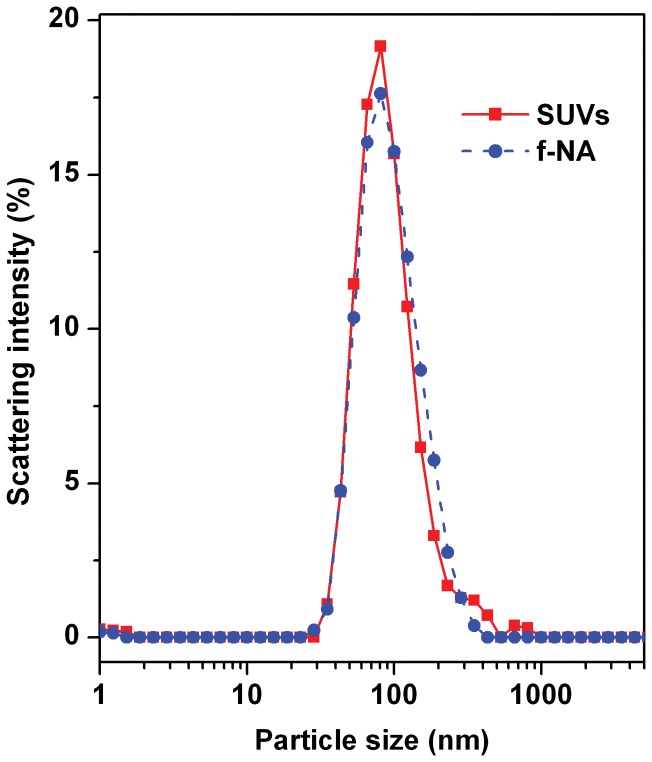
DLS particle size distribution profiles for SUVs and f-NAs.The sharp main peak for the SUVs (red) indicates they were formed with a narrow particle size distribution (d
average=104.8 nm, d
predominant=81.1 nm). The sharp main peak for f-NAs (blue) suggests they also had a narrow particle size distribution (d
average=102.3 nm, d
predominant=81.1 nm).